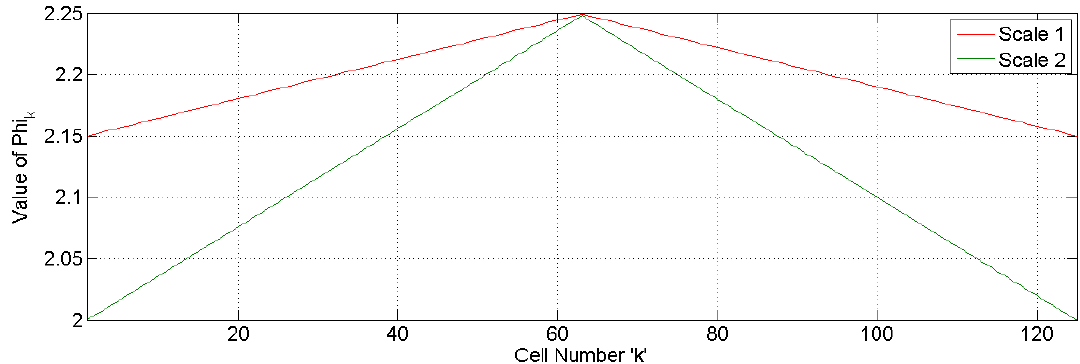
Figure 4. The values of φ k for different cells (LFP).